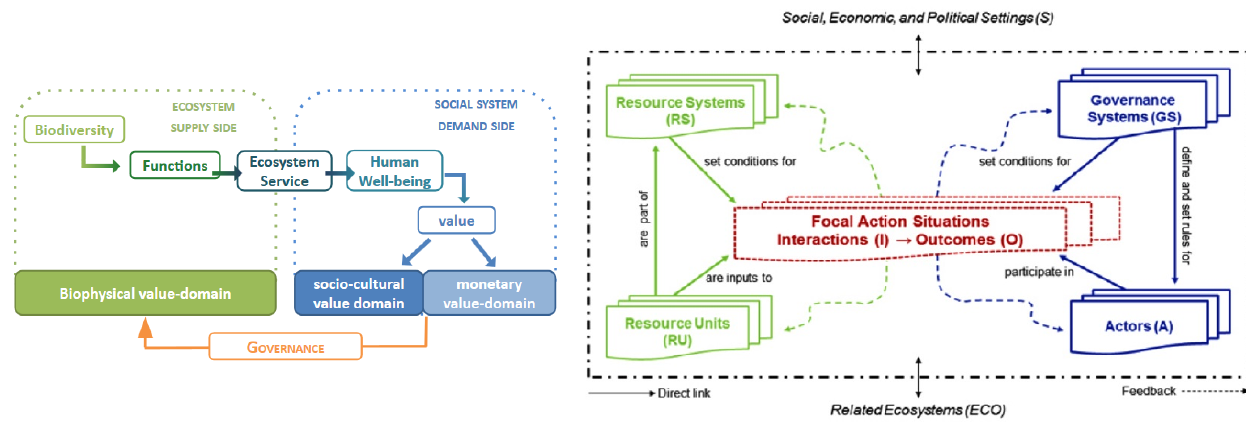
Fig. 2 . Side-by-side comparison of the ecosystem services (ES) cascade (left: adapted from Martín-López et al. 2014) and diagnostic SES framework (SESF) (right: McGinnis and Ostrom 2014). Both conceptual frameworks focus on the interactive processes between social (blue) and ecological (green) subsystems. There are more specific components that are nested within the categories of each, but they are not shown